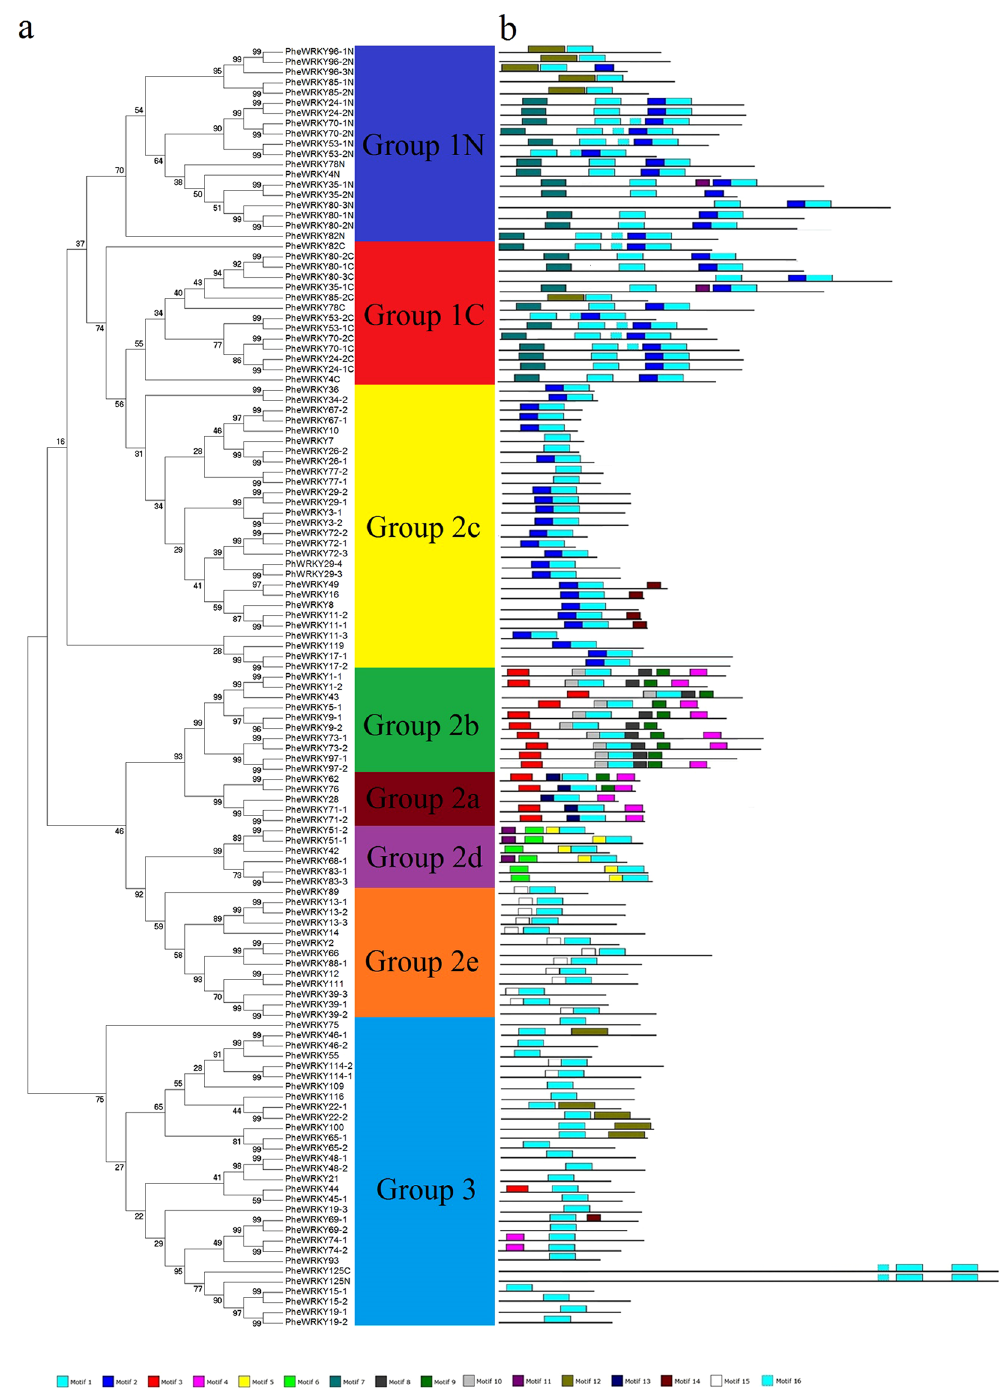
Figure 1. Phylogenetic analysis of the WRKY family of proteins in P. edulis (a) and the distribution of conserved motifs within each group (b)